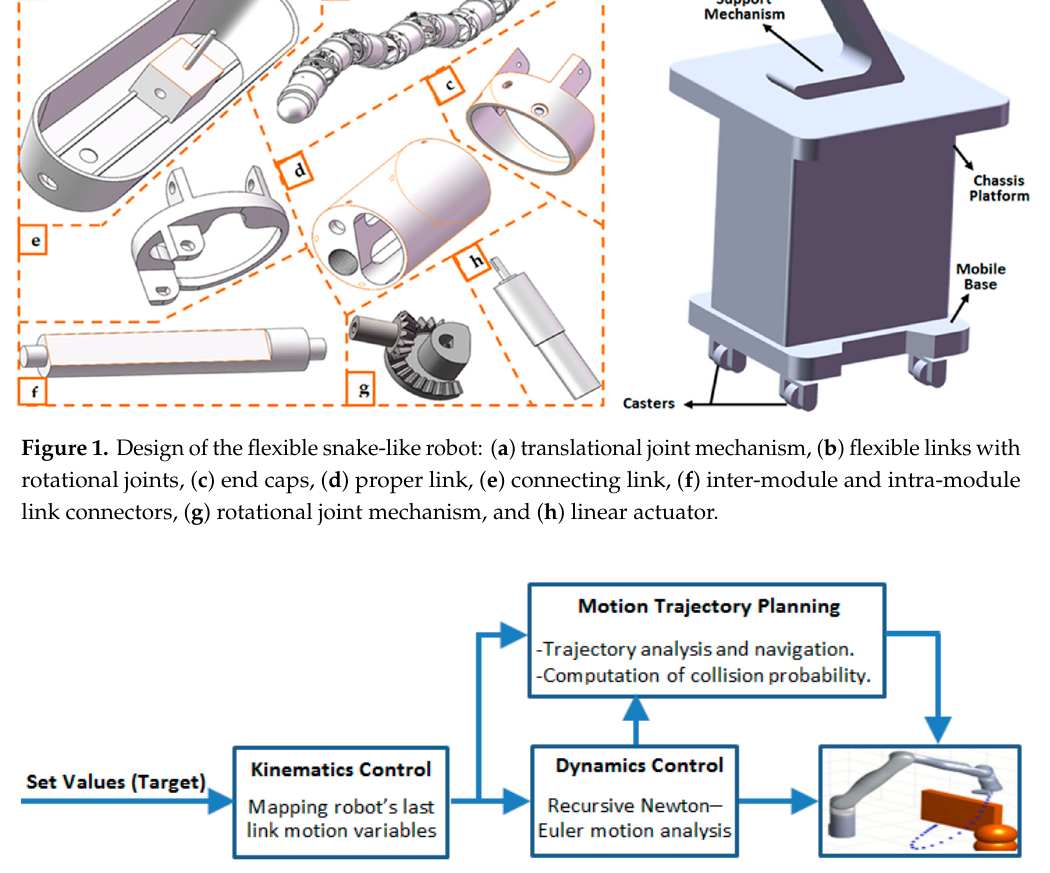
Figure 2. Operational flow of the control systems proposed for the flexible snake-like robot.